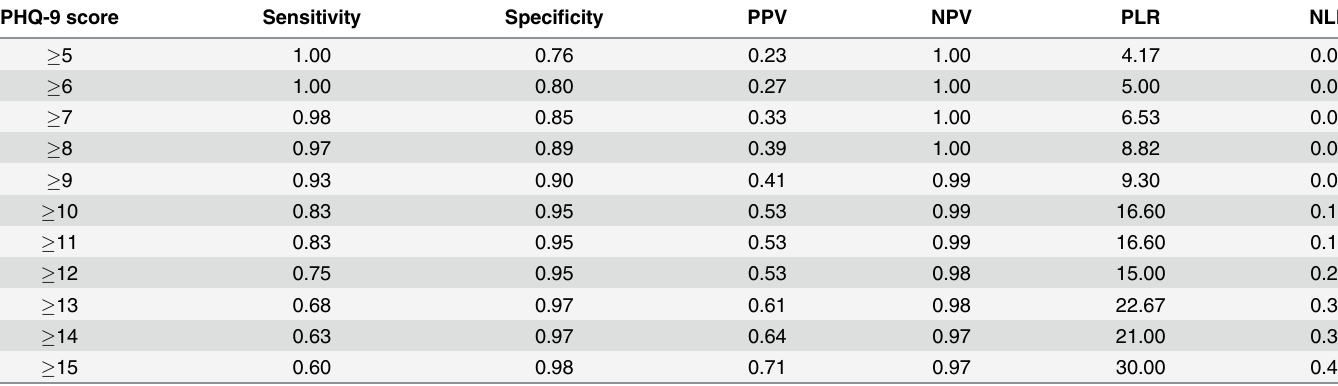
Table 3. Sensitivity, specificity, predictive values, and likelihood ratios at various cut-off scores of the PHQ-9. PHQ-9